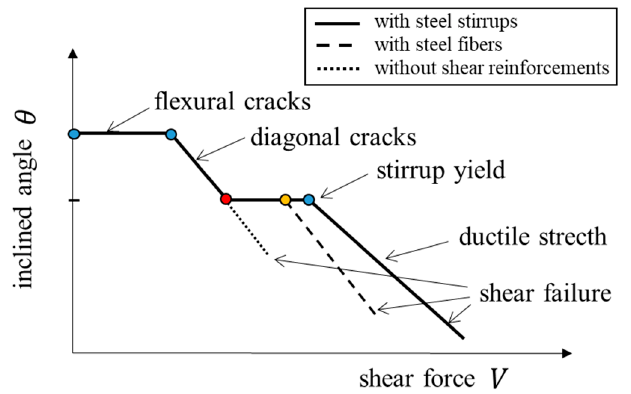
web reinforcement.